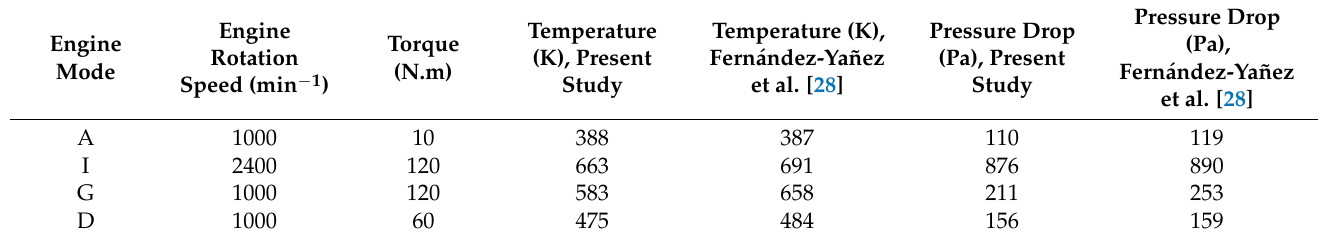
Table 2. Validation of the simulation data obtained by the present TEG model and that by Fern á ndez- Yañez et al.